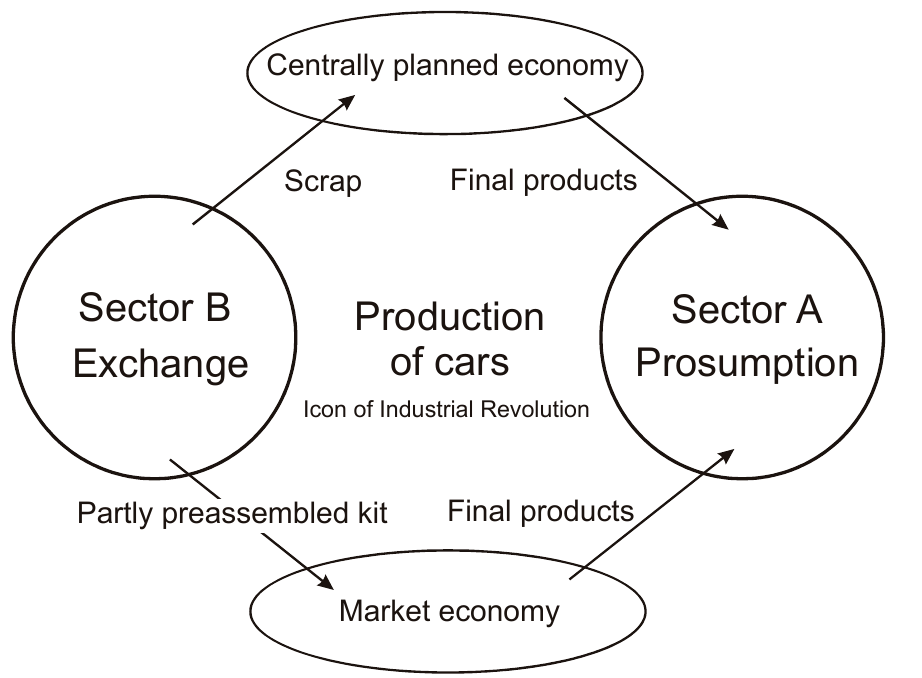
Figure 2. Car-building prosumption in a centrally planned economy and in market economy, and the relationship between Sectors A and B in both types of economies. Many micro and small hydropower plants were built in Poland in the years 1982–1989 in a prosumption system.